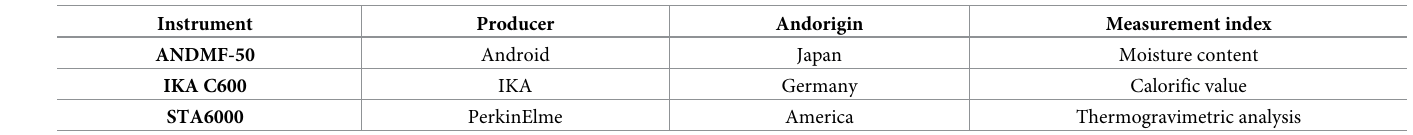
Table 1. Instrument